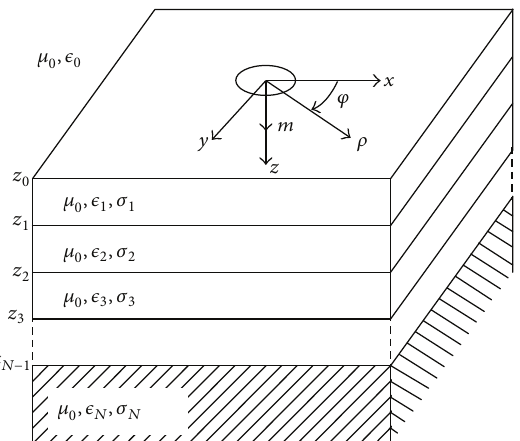
Figure 1: Sketch of a vertical magnetic dipole on a multilayer